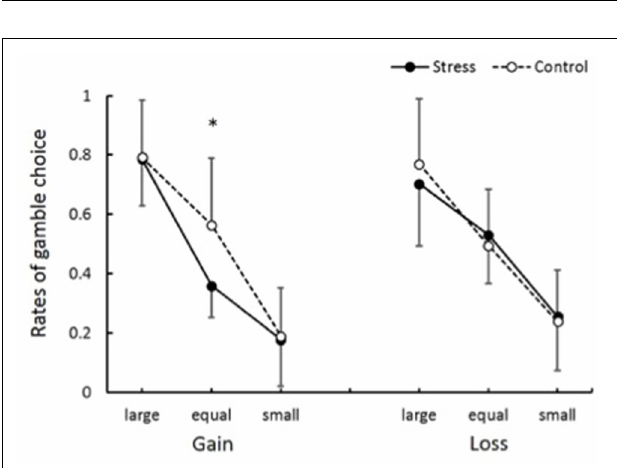
FIGURE 6 | Rates of gamble choice. ∗ Significant difference between groups ( p <